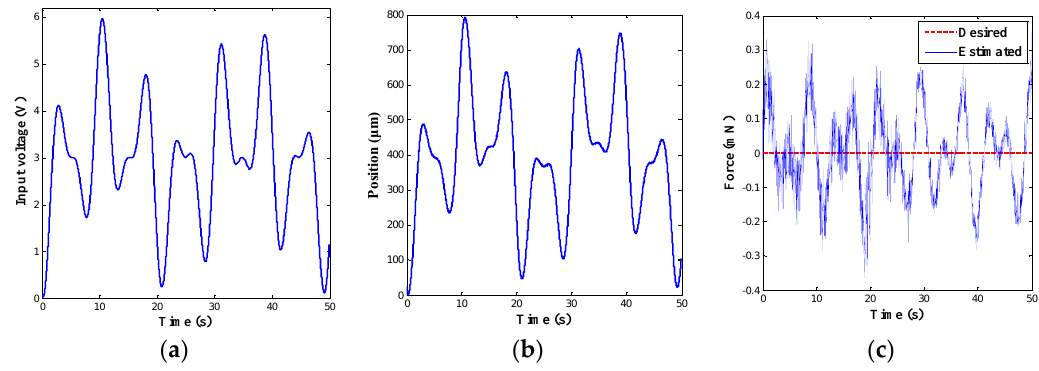
Figure 9. Estimation results of the force observer without gripping force. ( a ) Input voltage; ( b ) Output displacement; and ( c ) Force signal.